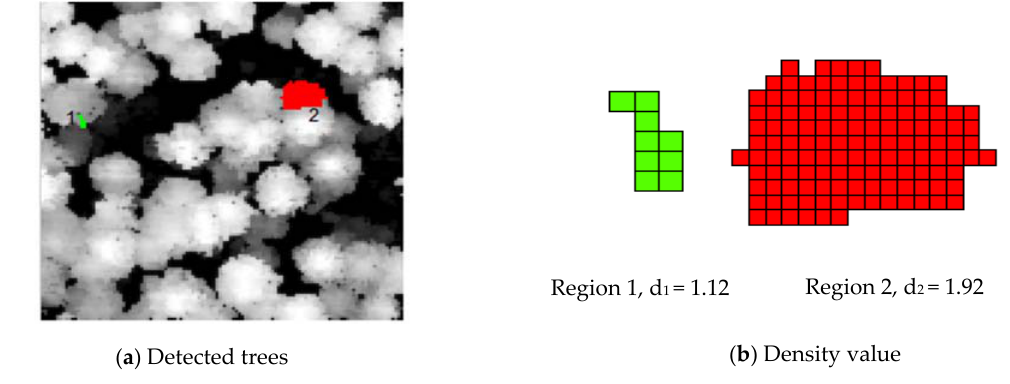
Figure 7. An example of single ‐ tree selection based on density feature. The green pixels and the red pixels represent region 1 and region 2, respectively.